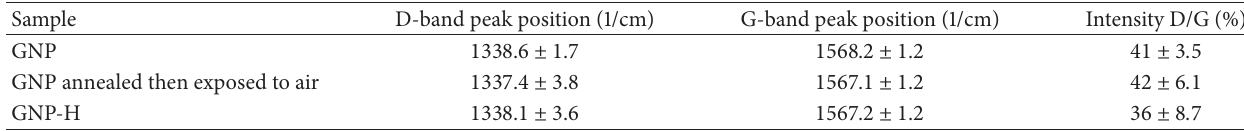
Table 3: Raman spectroscopy results for treated and untreated samples.